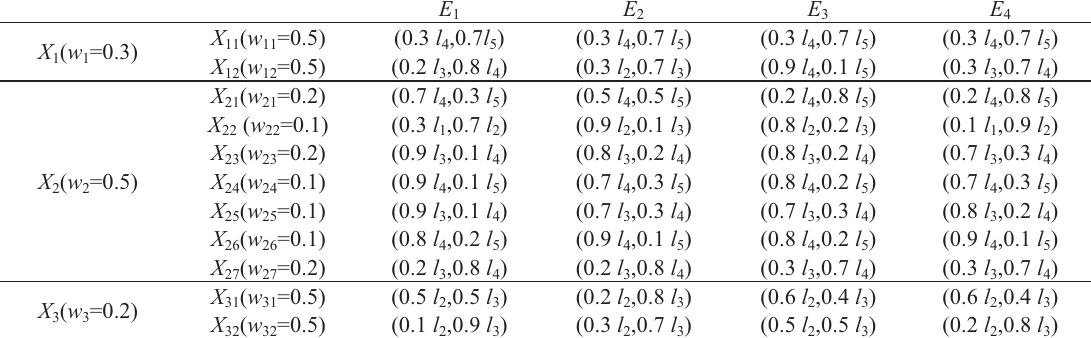
Table 1. The group decision matrix R 1 for South-line conformity project using PTLVs